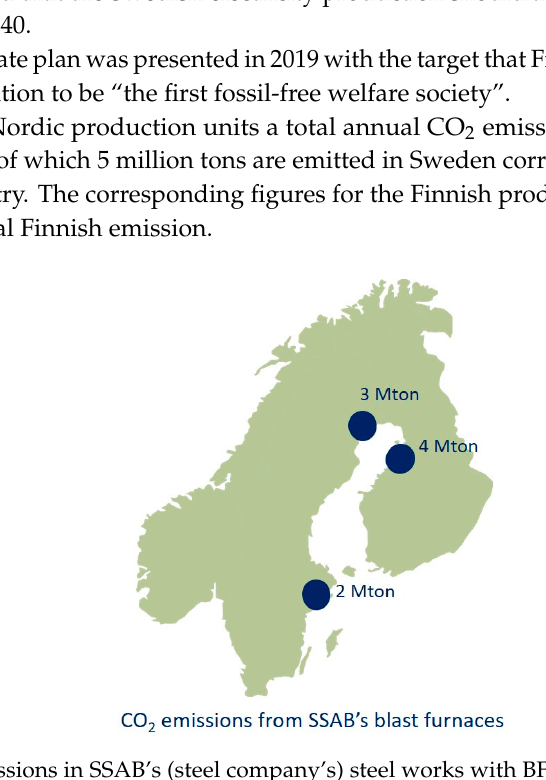
Figure 2. CO 2 emissions in SSAB’s (steel company’s) steel works with BF-BOF (Blast Furnace-Basic Oxygen Furnace) in Sweden and